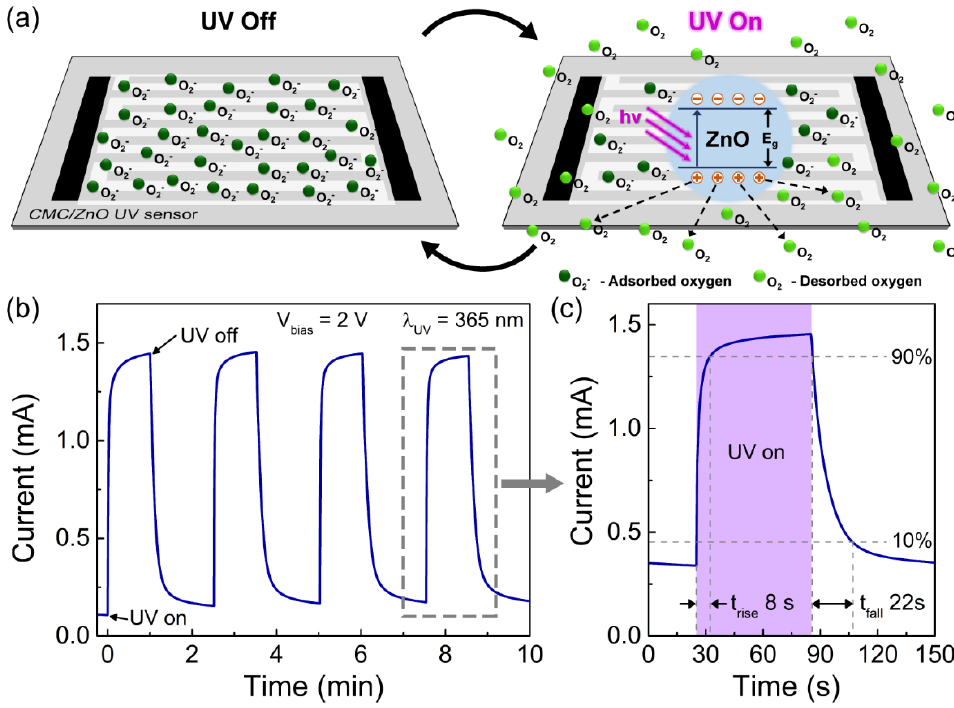
Figure 3. ( a ) Schematic of the UV sensing mechanism of the screen-printed CMC/ZnO UV sensor on office paper. ( b ) Average photoresponse of the UV sensor during several on/off UV cycles under a bias voltage of 2 V for a UV wavelength of 365 nm and an intensity of 8.66 mW cm −2 . ( c ) Magnification of one on/off UV cycle indicating the respective rise ( t rise ) and fall ( t fall ) times.